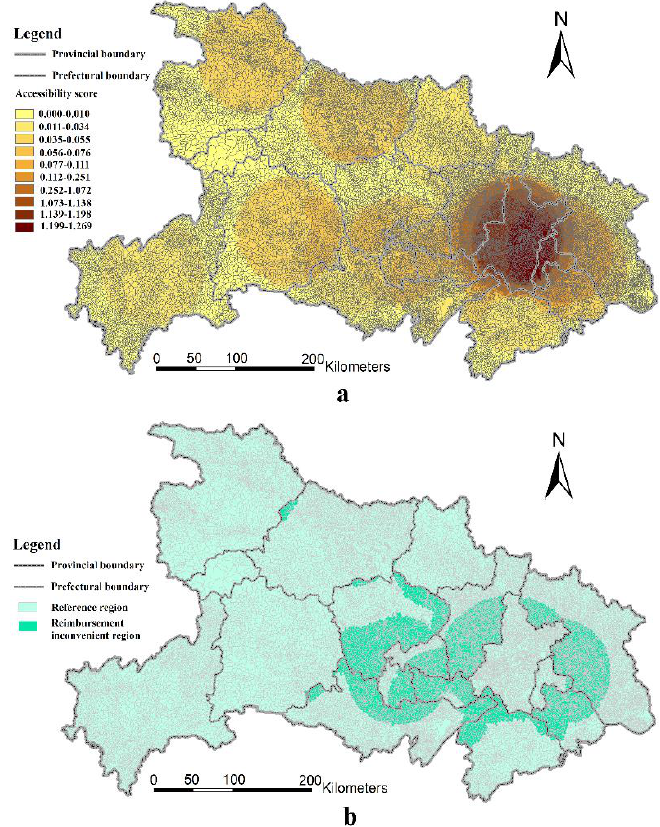
Figure 6. Accessibility ratios to Grade-A hospitals ( a ), and the geographical distribution of reimbursement inconvenience regions with respect to Grade-A hospitals ( b